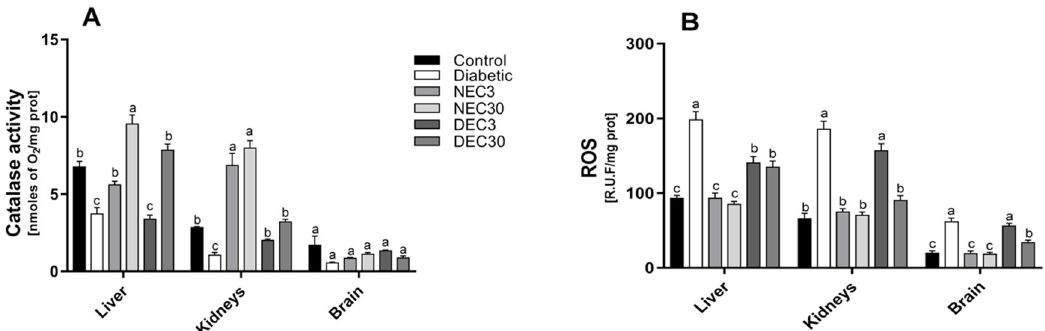
Figure 3. Effects of hexanic extract of E. carlinae on oxidative enzyme activity in rat tissues. ( A ) Catalase activity and ( B ) reactive oxygen species (ROS) production were determined in tissue homogenates. The results represent the means ± SE of three independent experiments. Different letters indicate significant differences between treatments p ≤ 0.05, two-way ANOVAs with Tukey’s post hoc test. NEC: normoglycemic + 3 mg of EC; NEC30: normoglycemic + 30 mg of EC; DEC3: